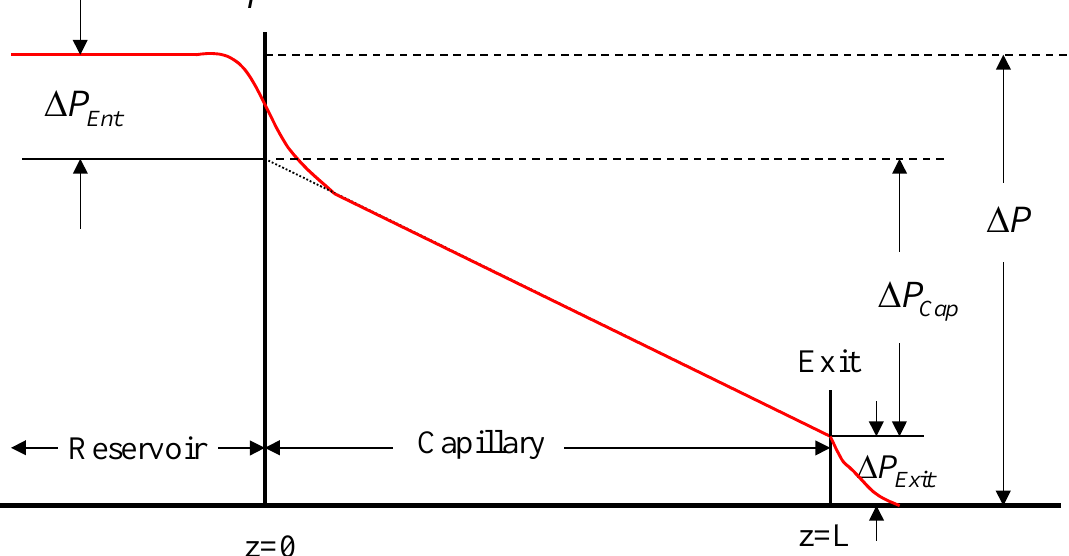
Polymers 2021 , 13 , x FOR PEER REVIEW Figure 1. Schematic diagram of the entry and exit pressure losses in flow through a capillary rheometer (reservoir to die).